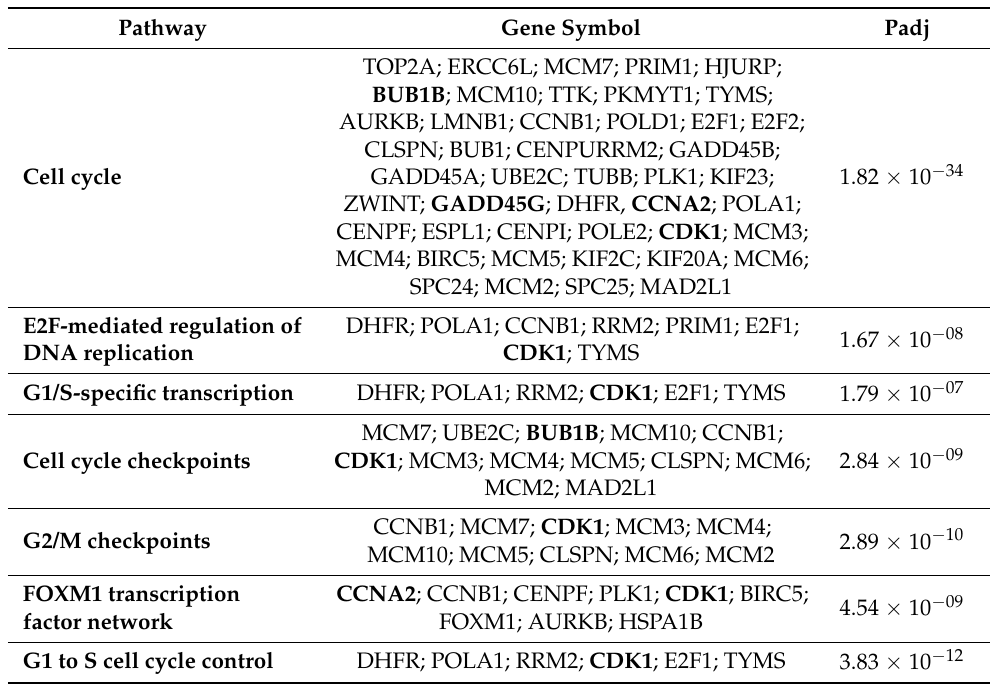
Table 4. Status of CRC-related genes—CDK1, CCNA2, BUB1B, GADD45G, and ATF3—in gene- pathway annotated networks. The table shows that CDK1 is prominently involved in different pathways. The gene pathways are significantly enriched in cell cycle-related networks. Padj: adjusted p